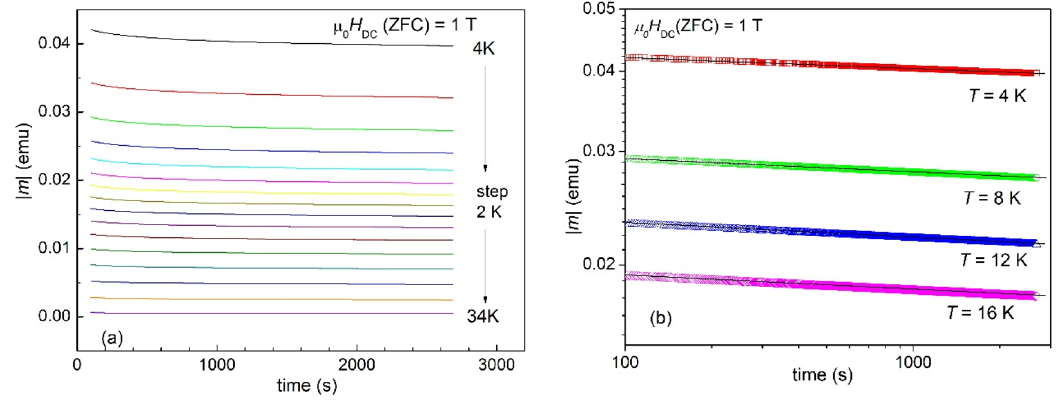
Figure 2. Magnetization relaxation measurements after zero-field-cooling (ZFC) in 1 T, at various temperatures between 4 and 34 K, step 2 K, excluding initial data for t < 100 s due to magnetic flux lines rearrangement ( a ); double logarithmic plot of selected (for clarity) magnetic relaxation data. Straight lines provide the slopes of the dln(| m |)/dln( t ), averaged up to t w = 2700 s, from which the (dimensionless) normalized relaxation rate S = − dln(| m |)/dln( t ) can be determined ( b ).